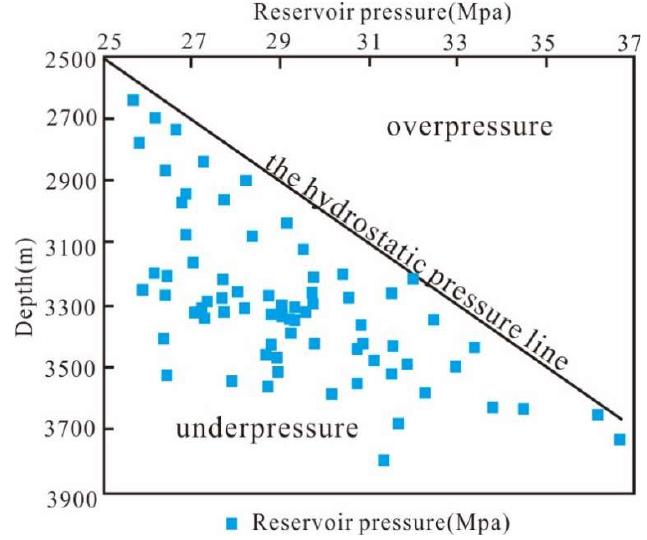
Figure 4. Relationship between reservoir pressure and depth.